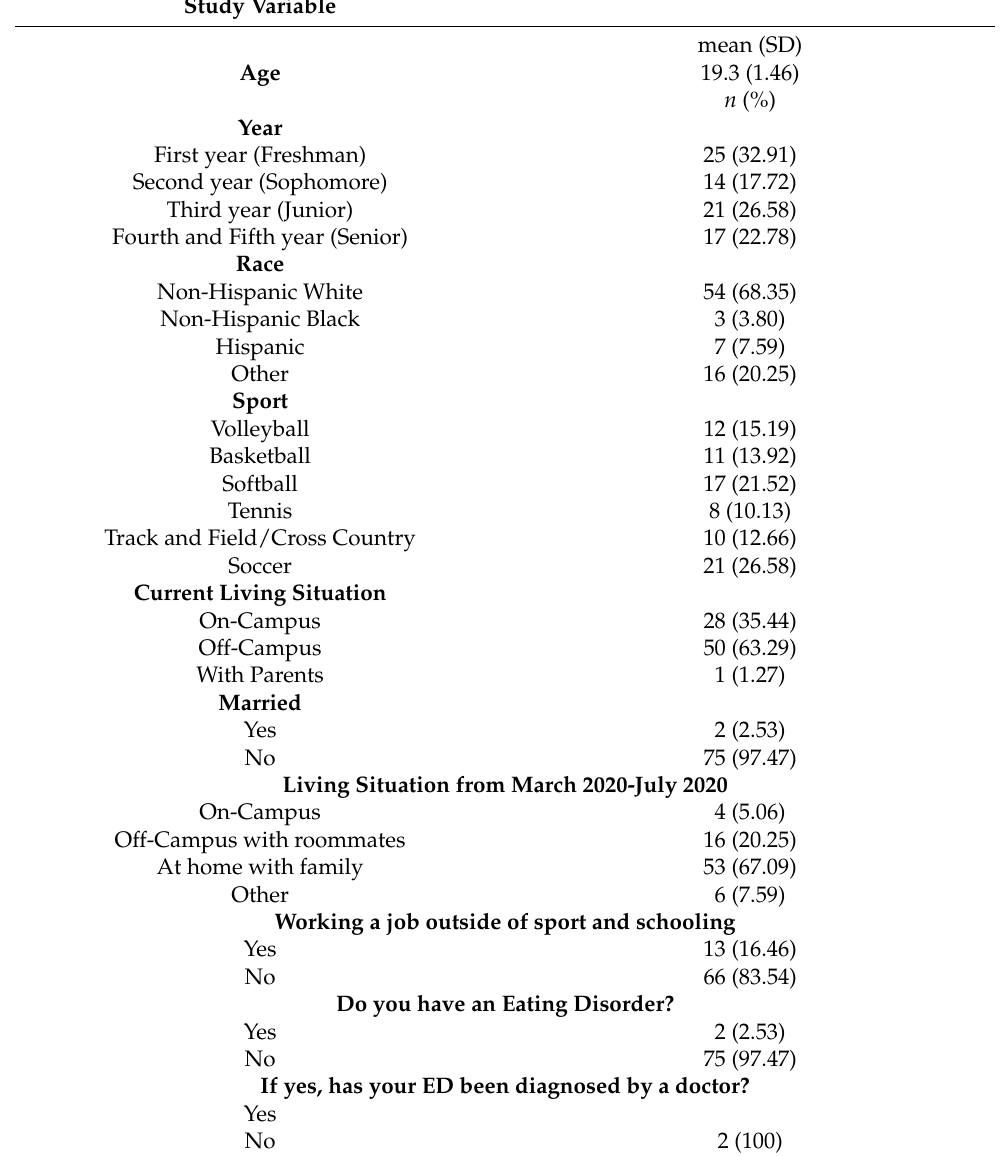
Table 1. Demographics and key variables for the female student athletes ( n = 77). Study